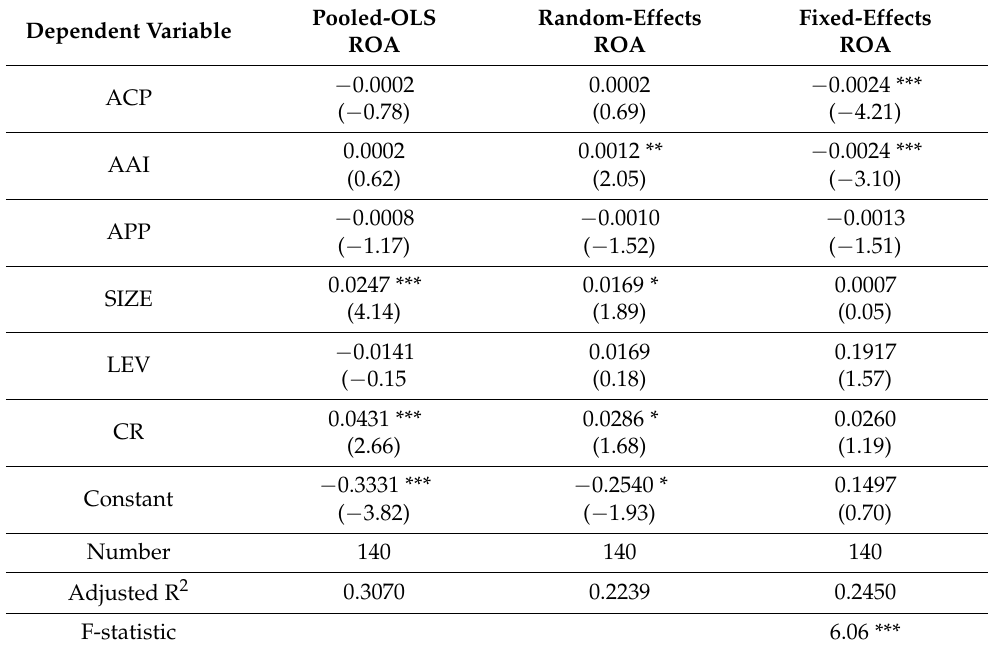
Table 4. Panel regression results with ROA as the dependent variable.